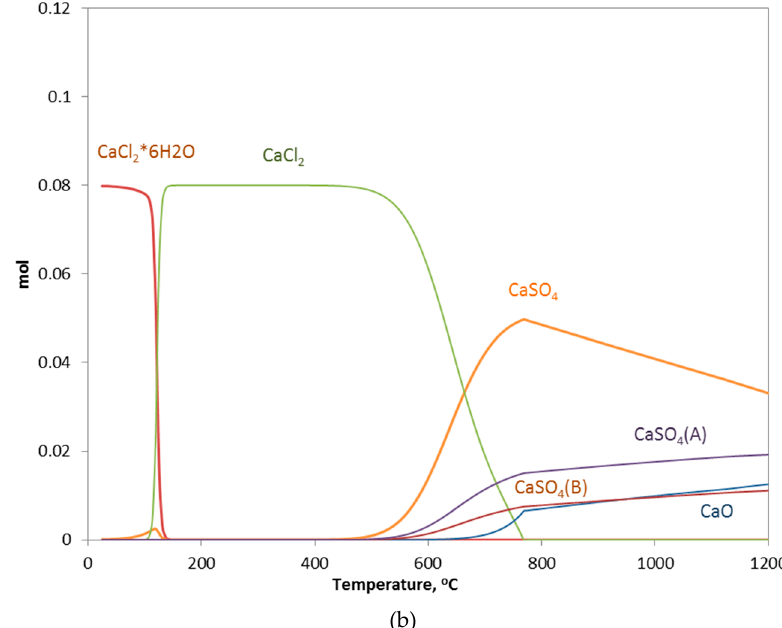
Figure 12. Produced solid and gas phases from the aqueous stream after calcium sulfate precipitation, increasing the temperature from 25 to 1200 °C, based on HSC equilibrium calculations. ( a ) Release of HCl gas and evolution Mg phases; ( b ) evolution of Ca phases.